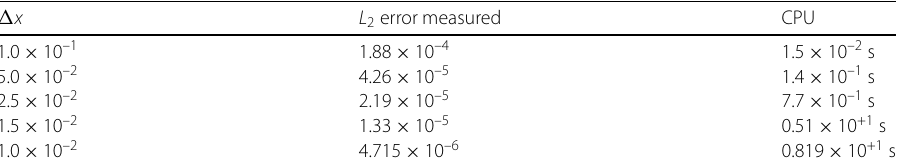
Table 1 L 2 errors and CPU times consumed to arrive at t = 5 for the numerical technique (cid:10)